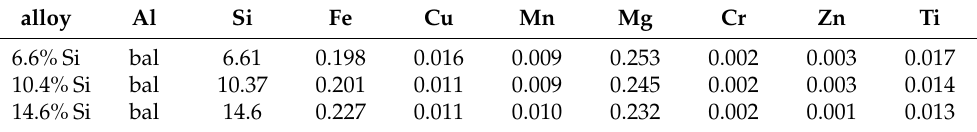
Table 1. Chemical composition of the custom-made Al alloys by element in weight-%.